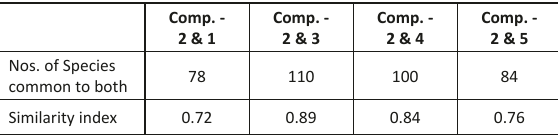
Table 3. Degree of similarity between Compartment 2 with other compartments of